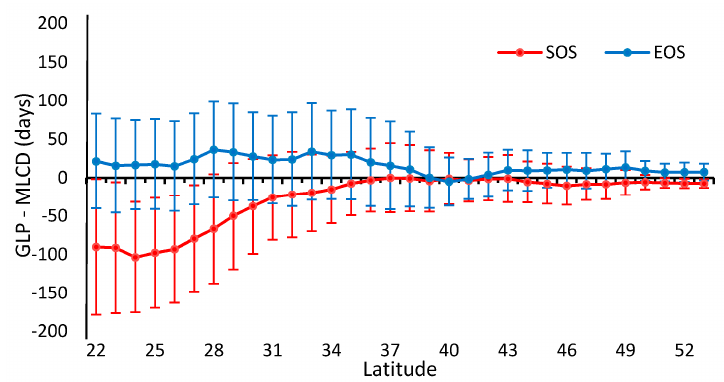
Figure 8. The difference values between the GLP and the MLCD in different latitudinal bands.